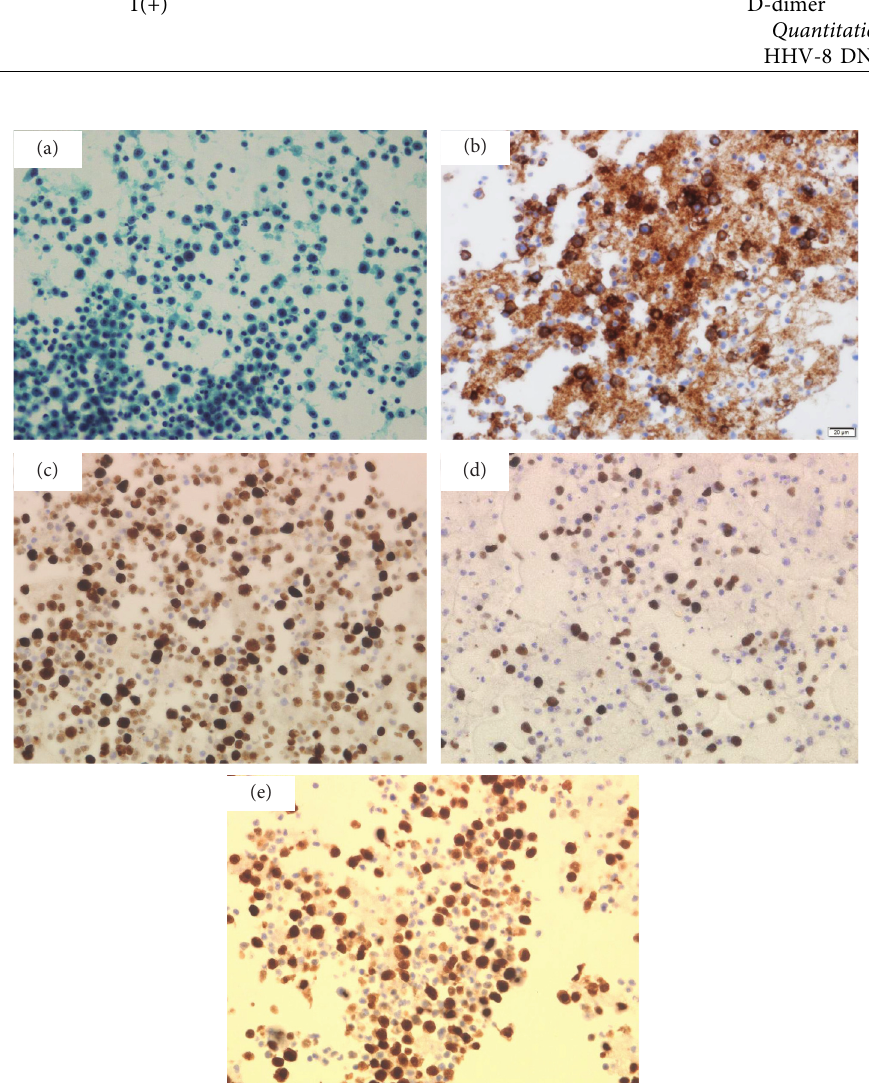
Figure 3: Cytological pericardial effusion findings. (a) Pap staining ( × 40). Cell block with ((b)–(e)) immunocytochemical findings. (b) CD20. (c) Ki-67 (MIB-1 index 50%). (d) EBER. (e) MUM-1 ((b)–(e) ×